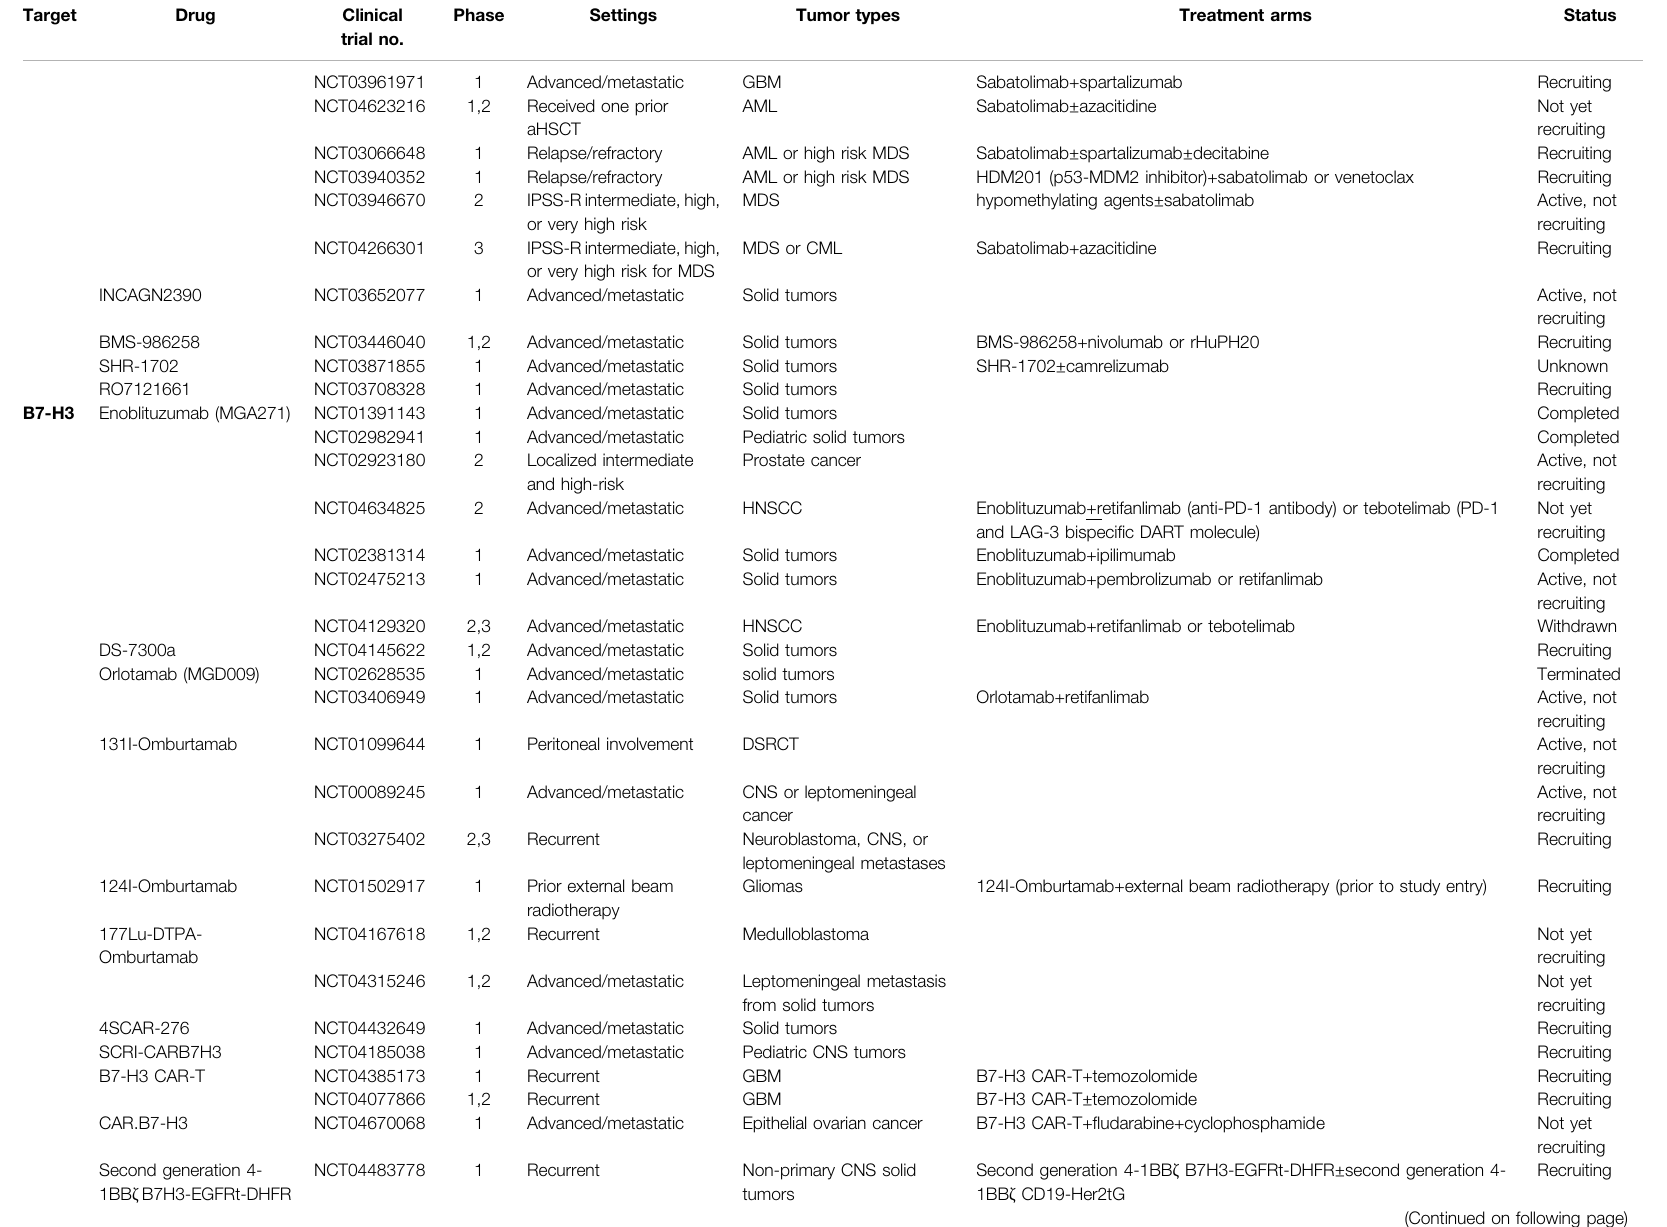
TABLE 3 | ( Continued ) Clinical trials on novel immune checkpoint